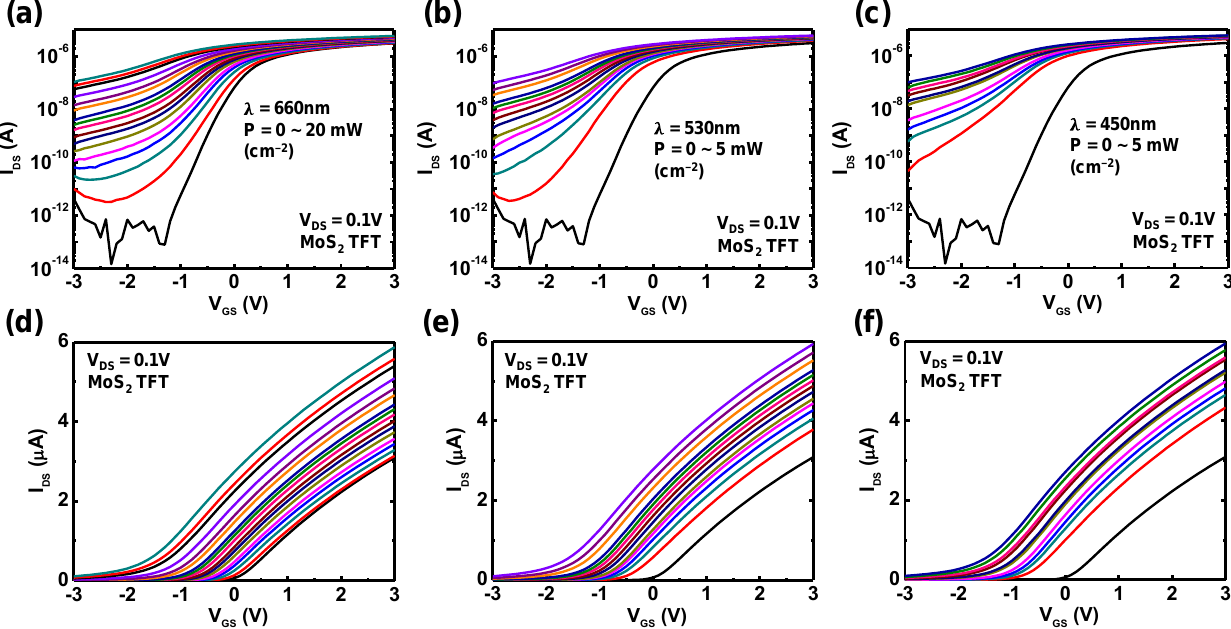
Figure 3. Transfer characteristics of m-MoS 2 TFTs under illumination at 660, 530, and 450 nm using lasers in ( a – c ) log and ( d – f ) linear scale at V DS = 0.1 V. Various optical intensities (0~5 mW cm – 2 ) were applied to a-Si:H TFTs with the same distance and angle.